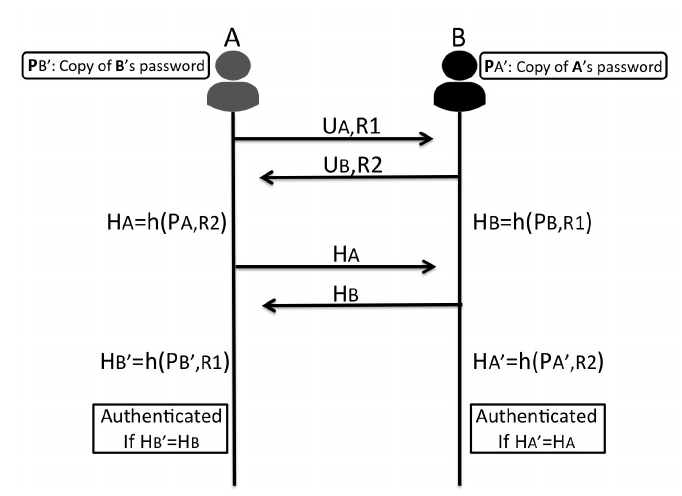
Figure 2. User handshake protocol for user